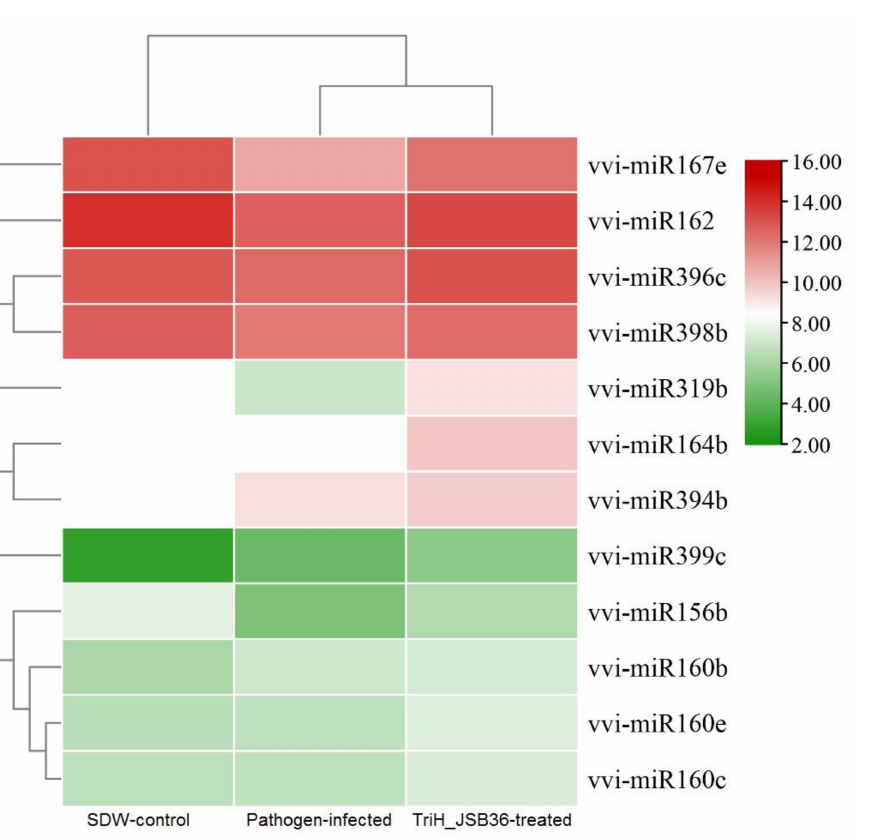
Figure 8. Expression of target mRNA transcript by qRT-PCR in response to SDW-control, pathogen-infected, and TriH_JSB36- treated plants. The heatmap was developed using Log 2 value from the Rstudio program (A package of R,